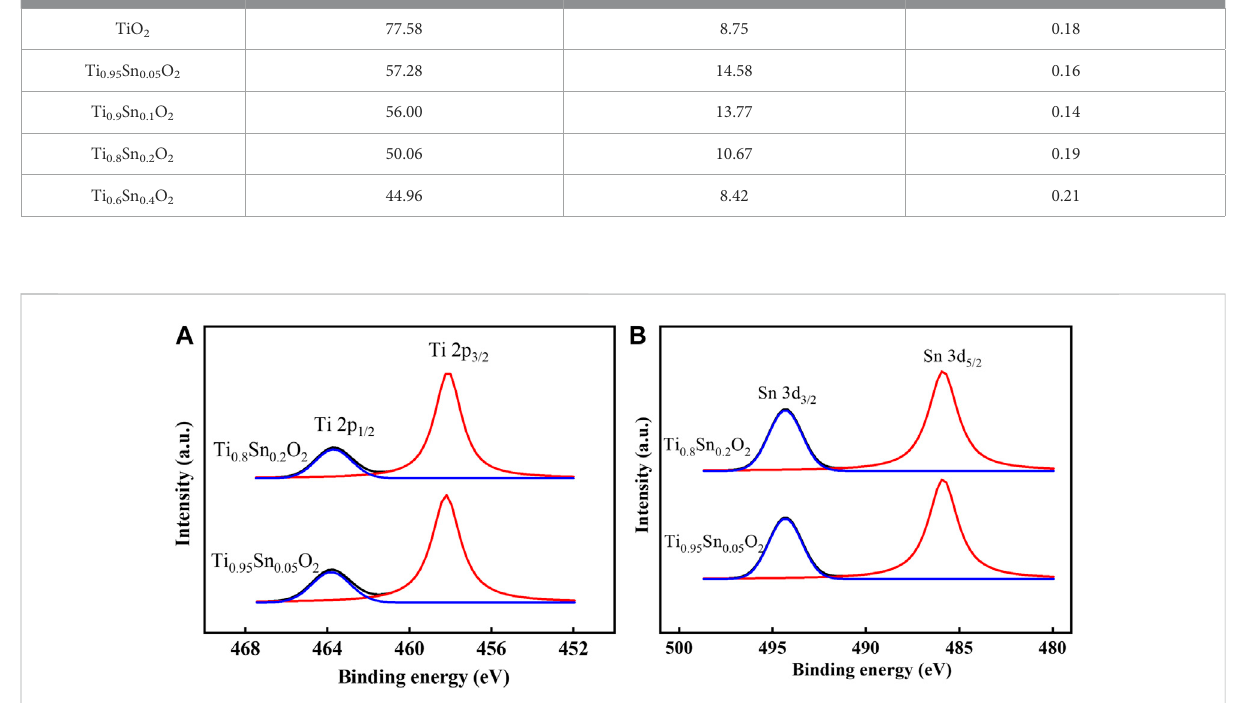
XPS curves fi tted of (A) Ti 2p spectra of Ti 0.95 Sn 0.05 O 2 and Ti 0.8 Sn 0.2 O 2 , (B) Sn 3 d spectra of Ti 0.95 Sn 0.05 O 2 and Ti 0.8 Sn 0.2 O 2 .